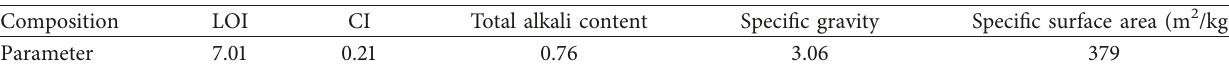
Table 2: Main physical parameters of iron tailings powder.